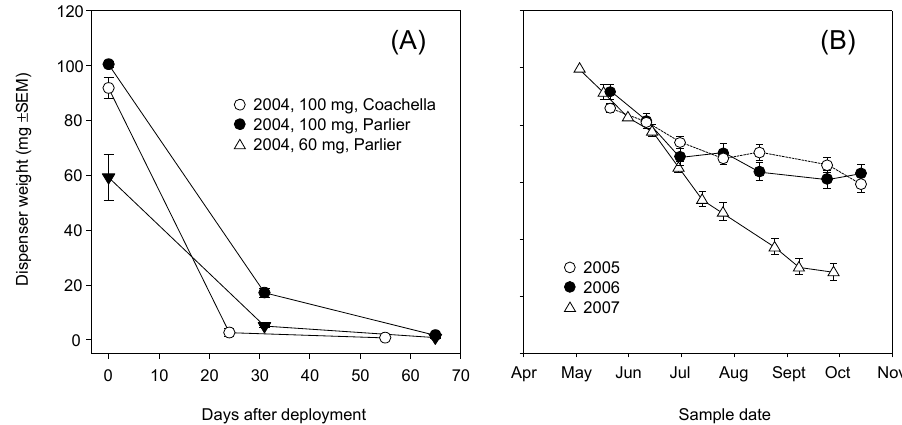
Figure 12. Release of synthetic pheromone for ( A ) 2004 and ( B ) 2005–2007, as determined by the weight of pheromone remaining in dispensers placed in the field (Parlier or Coachella valley) and collected every 2 weeks.